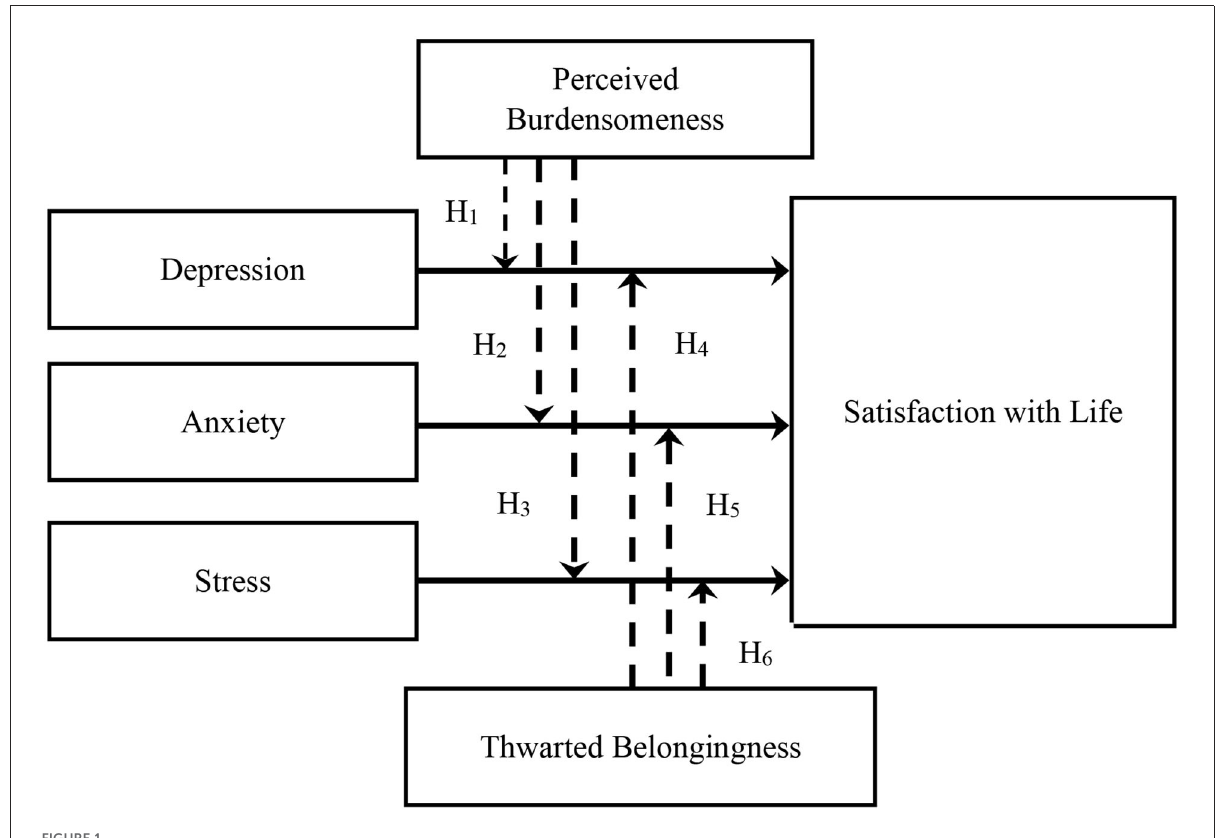
FIGURE1 Research